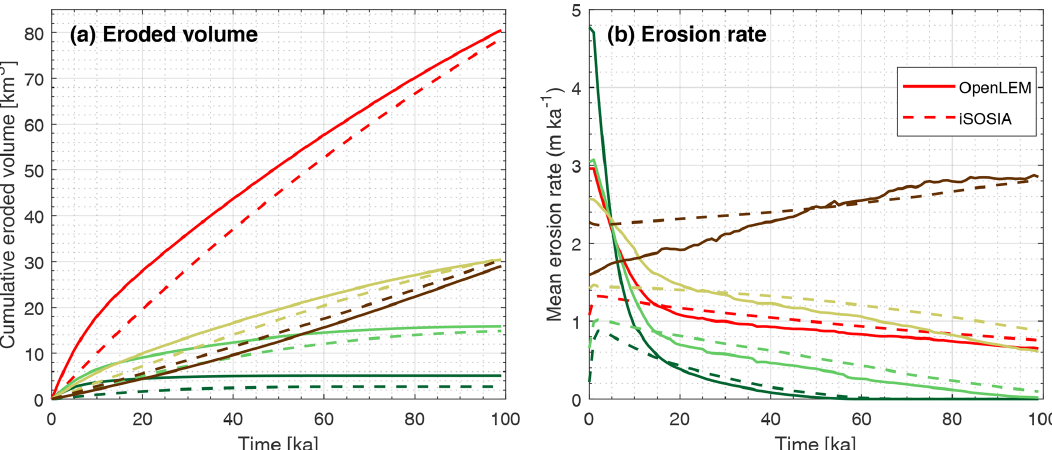
Figure 7. Differences and similarities in the erosion history as computed by iSOSIA (dashed lines) and OpenLEM (solid lines). (a) Cumu- lative eroded volume and (b) mean erosion rate of the entire landscape (red lines) and the rising elevation ranges as shown in Fig.